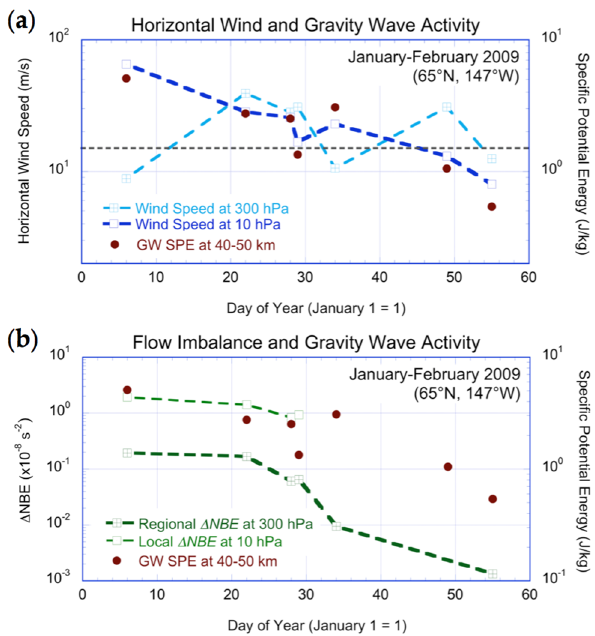
Figure 12. ( a ) Specific potential energy (SPE) and horizontal wind speed in January–February 2009 for the day of year; ( b ) SPE and ageostrophy plotted in January–February 2009 as the day of year. The day of year counts from 1 on 1 January and day of year 30 corresponds to 30 January. Regional Δ NBE represents the areal average poleward of 50° N. Local Δ NBE represents the areal average over the 800-km circle centered on Chatanika.